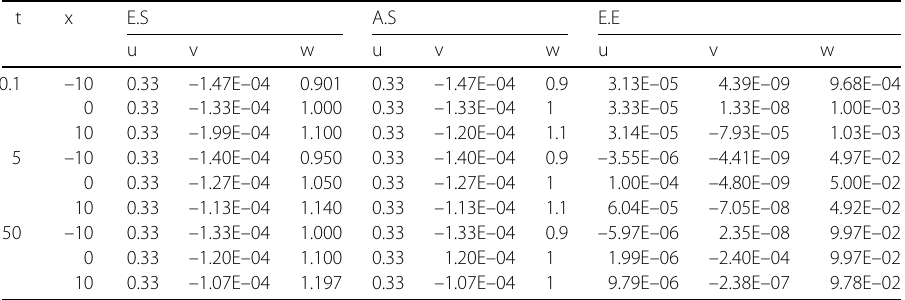
Table 1 Approximate solutions, exact solutions, and error estimates for the Elzaki iterative transformation method when α is 1 for Example